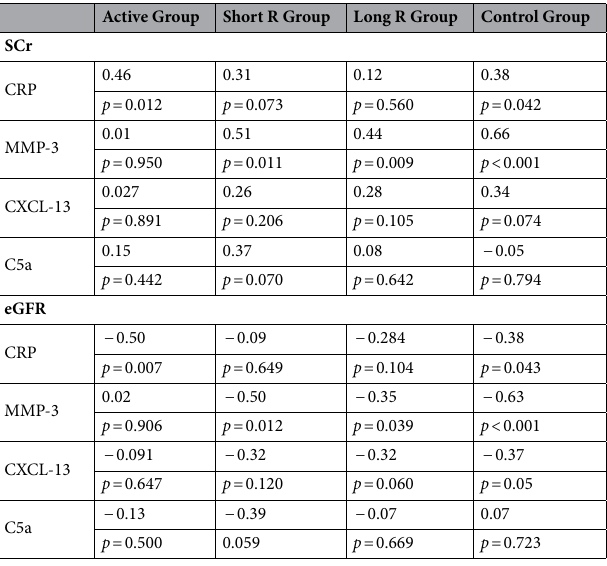
Table 5. Correlations between serum creatinine concentration or eGFR and inflammatory markers in the studied groups.